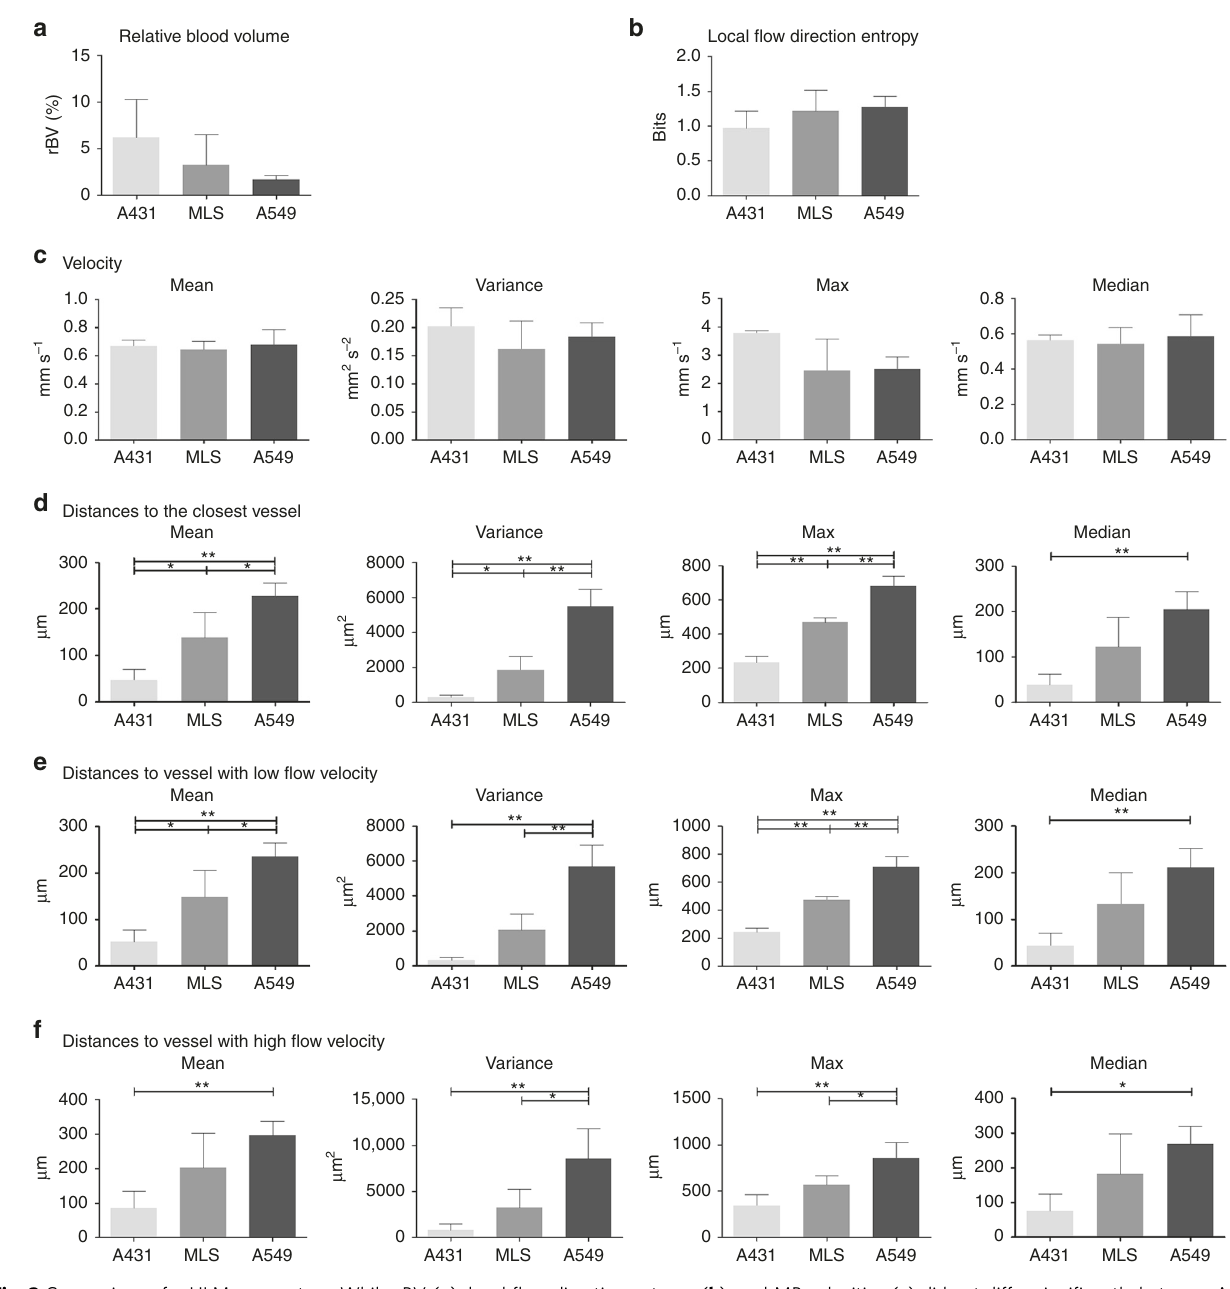
Fig. 3 Comparison of mULM parameters. While rBV ( a ), local fl ow direction entropy ( b ), and MB velocities ( c ) did not differ signi fi cantly between A431, MLS, and A549 tumors, the tumor models could be distinguished using the parameters of distances to the closest vessel ( d ), and the parameters that combined velocity and distance information, i.e., distances to vessel with low ( e ) and high velocities ( f ). Only parameters that could distinguish all three tumor models were used for further analysis. For all bar plots shown, data are expressed as the mean ± s.d. ( n = 4 per tumor model; ** p < 0.01; * p < 0.05 by one-way ANOVA with Bonferroni post-hoc